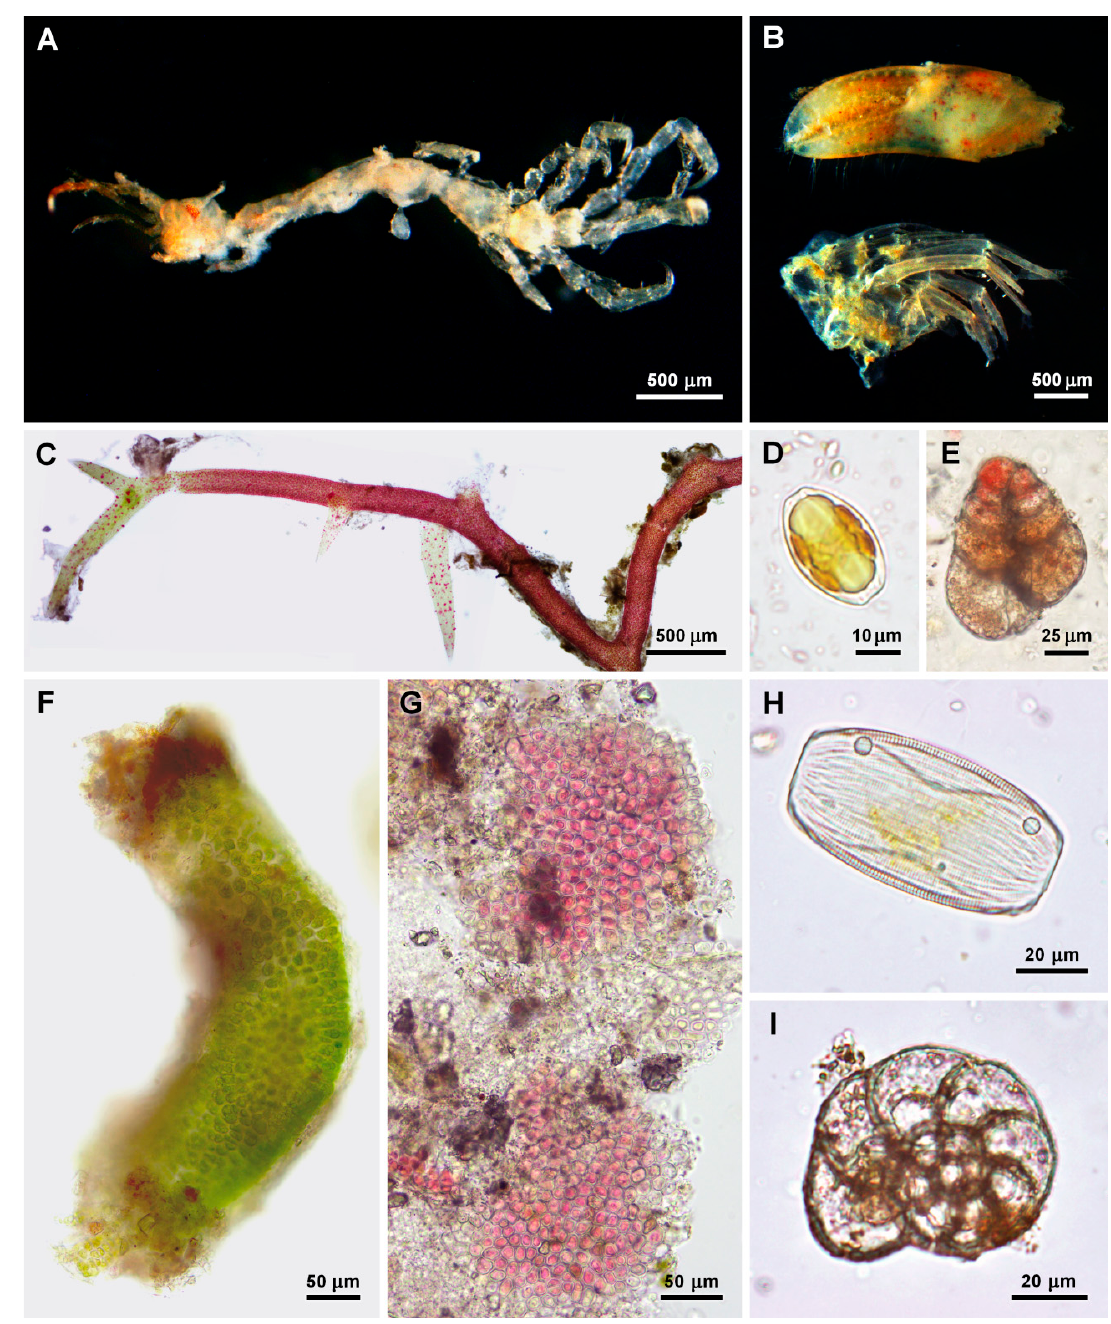
Figure 2. Digestive tract content. ( A – E ) A caprellid amphipod ( A ), fragments of other crustaceans ( B ), a piece of red algae ( C ), a diatom ( D ) and a foraminiferan ( E ) from the stomach of C. angulata .